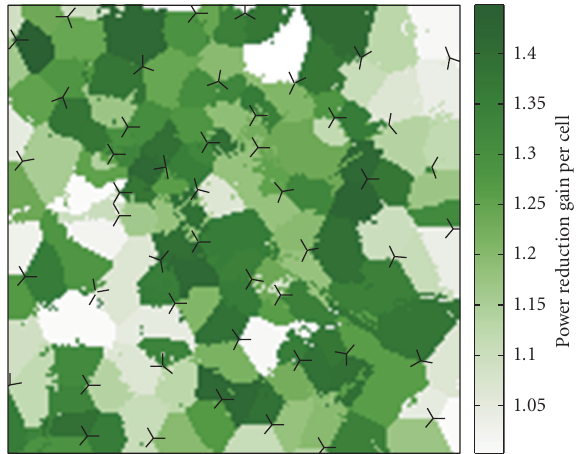
Figure 9: Power gain per cell resulting from cell unloading with δ = δ ( B )